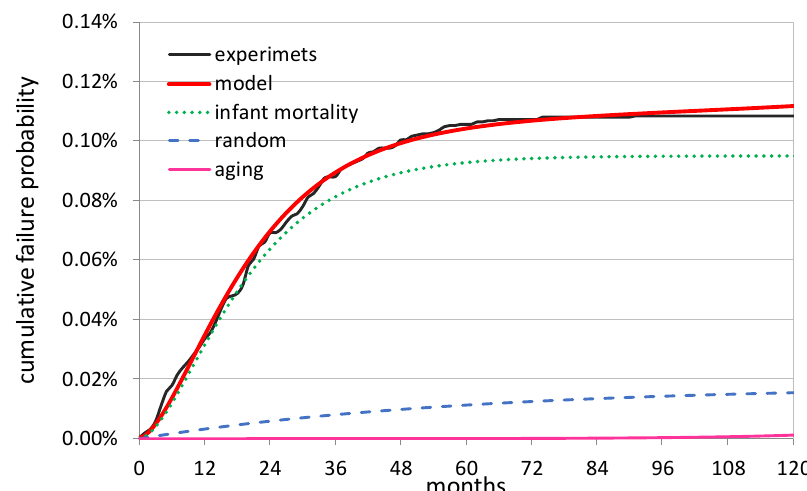
Figure 5. Failure probability density function of microcontrollers: experimental data, model and single components of the model.